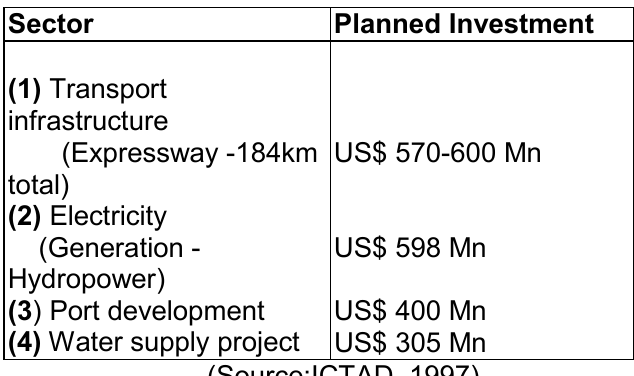
Table-3. Public Sector planned investment in infrastructure